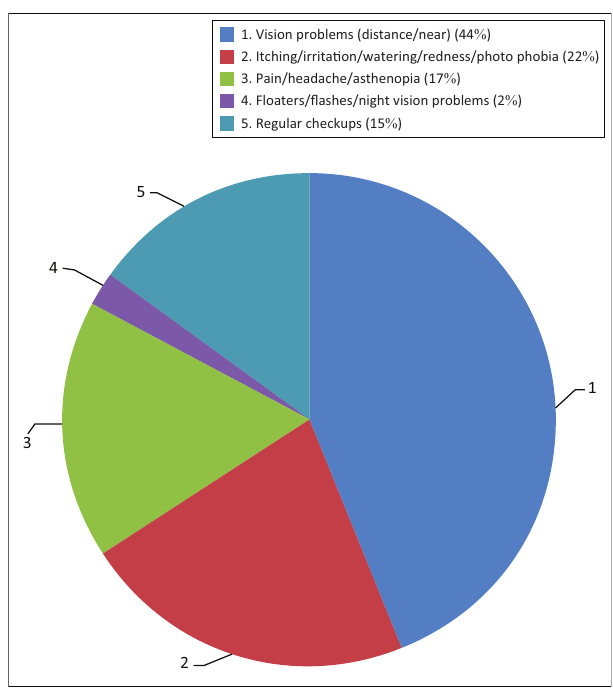
FIGURE 2: Percentage of patients who reported symptoms during their visit.